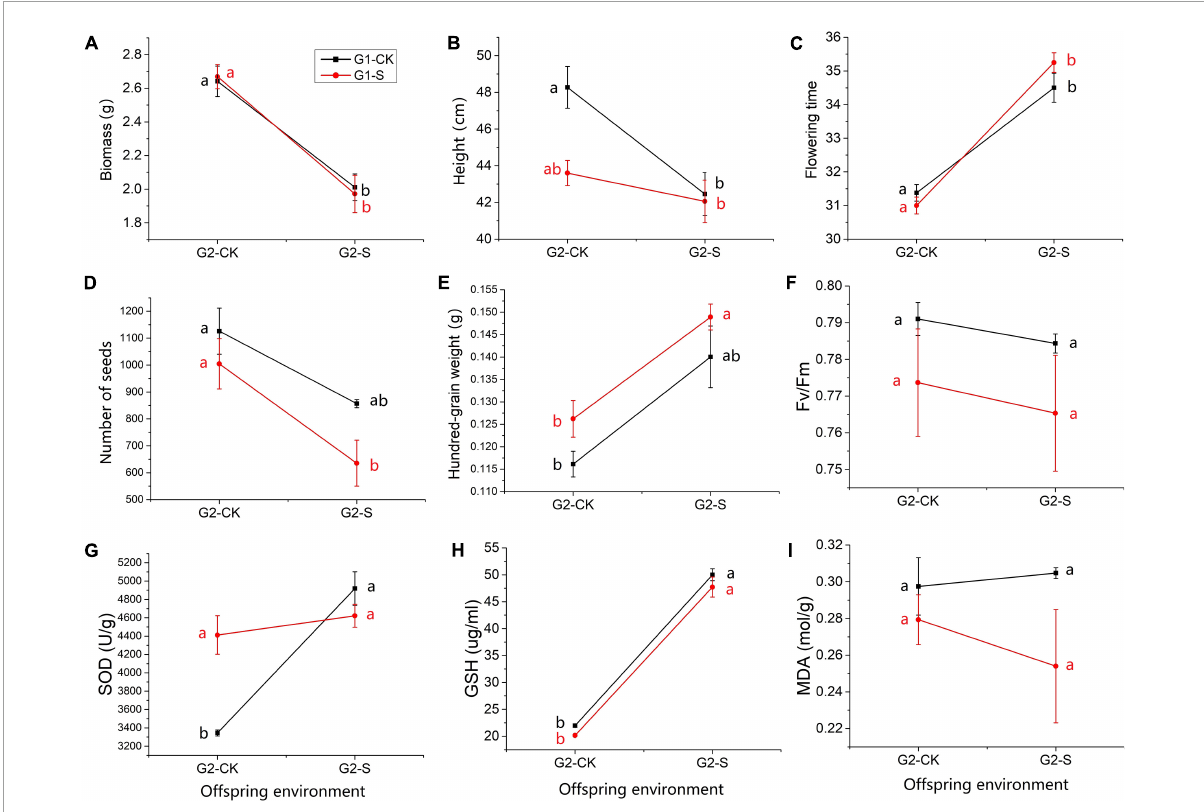
FIGURE3 Reaction norm of trait expression in G2 individuals exposed to soil Cd concentrations of 0 mg/kg (CK) and 185 mg/kg (S). The red and black lines show seedlings that originated from offspring of Cd185 (S) and CK treatment in G1, respectively. (A) Biomass; (B) individual height; (C) flowering days; (D) number of seeds; (E) hundred-grain weight; (F) Fv/Fm; (G) SOD; (H) GSH; and (I) MDA. Quoted values are means ± SE ( N = 6). Different letters indicate significant differences among groups determined by Tukey’s